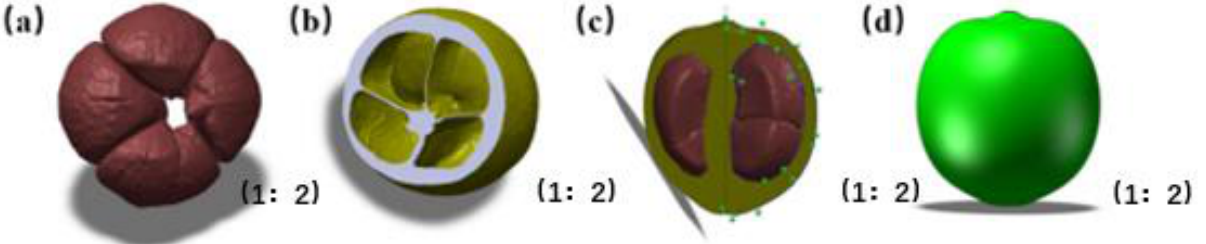
Figure 5. Solid model and model simplification of the Camellia oleifera fruit. ( a ) Camellia seed model. ( b ) Shell model. ( c ) Spline curve extraction. ( d ) Simplified fruit